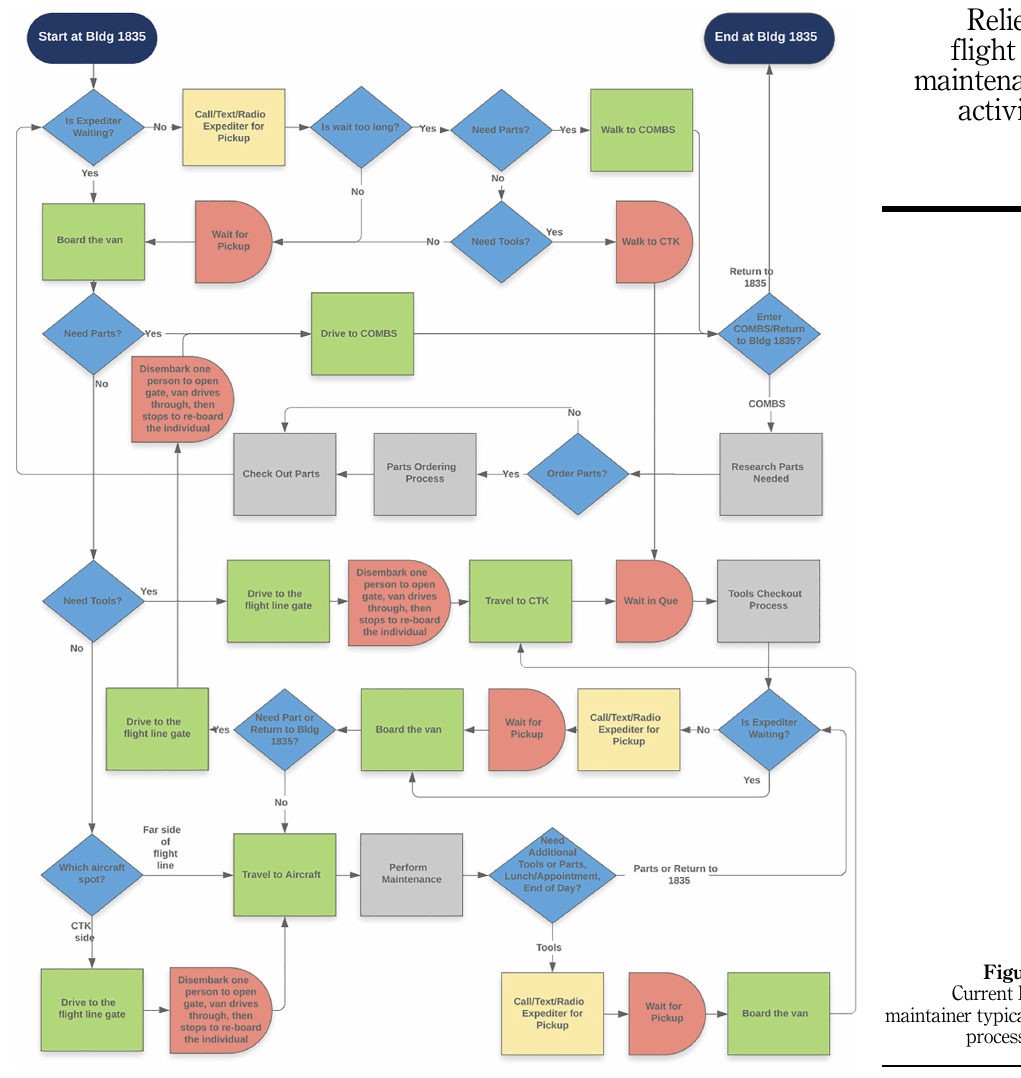
Figure 3. Current